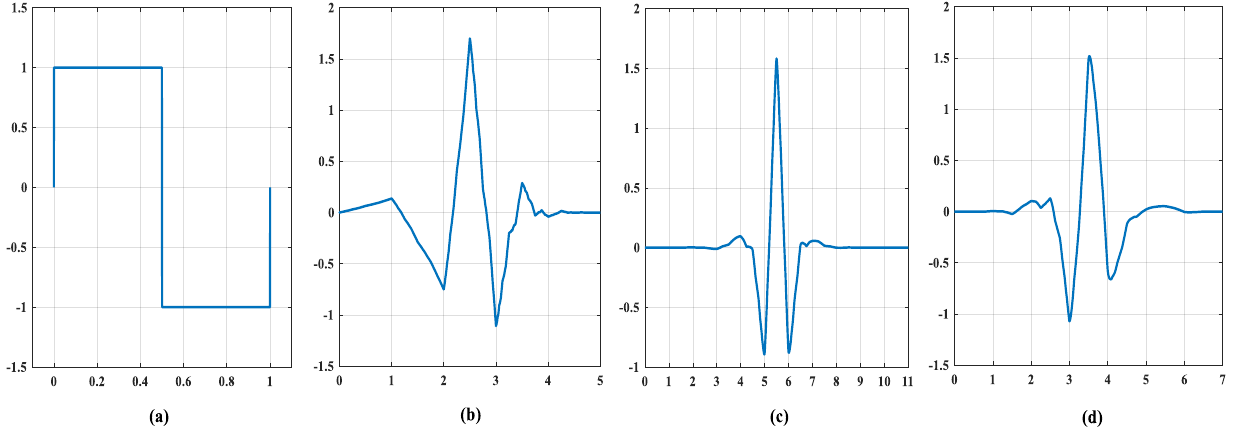
Figure 1. Sample illustration of various wavelet mother functions: ( a ) haar, ( b ) db3, ( c ) coif2, and ( d ) sym4.